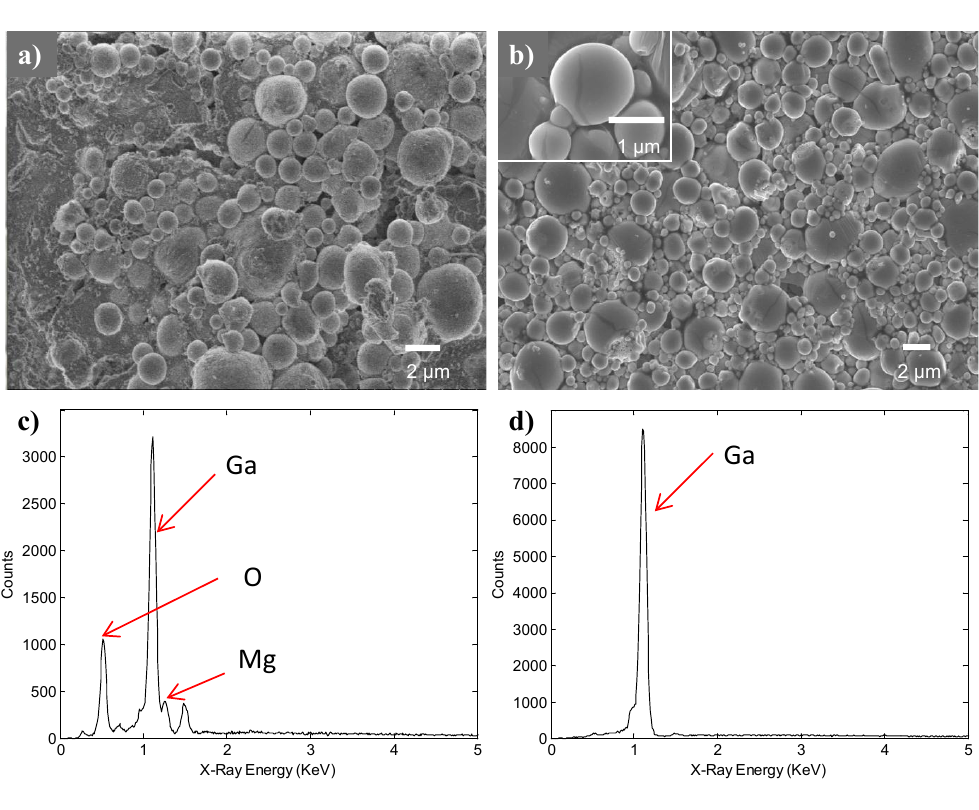
Figure 2. Field emission scanning electron microscope (FESEM) images and energy dispersed spectroscopy (EDS) analysis of the deposition: ( a ) gallium particles with magnesium compounds holding layer; ( b ) gallium particles after the removal of magnesium compounds and a magnified view of a few particles showing cracks on the oxide “shell” as inset; ( c ) EDS of the film before removal of magnesium compounds; and ( d ) EDS of the film after removal of magnesium